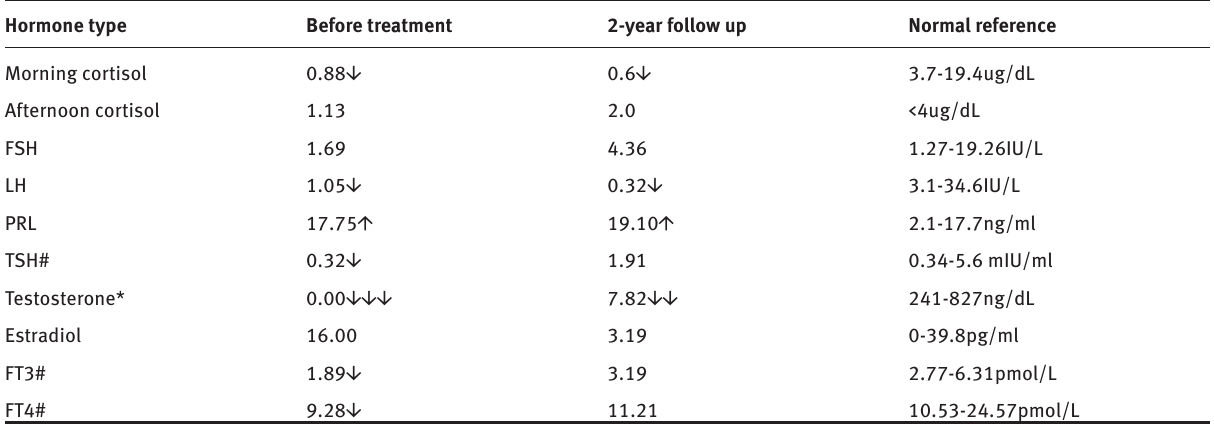
Table 1: Endocrine tests of hormones before treatment and 2 years after coiling of the aneurysm Hormone